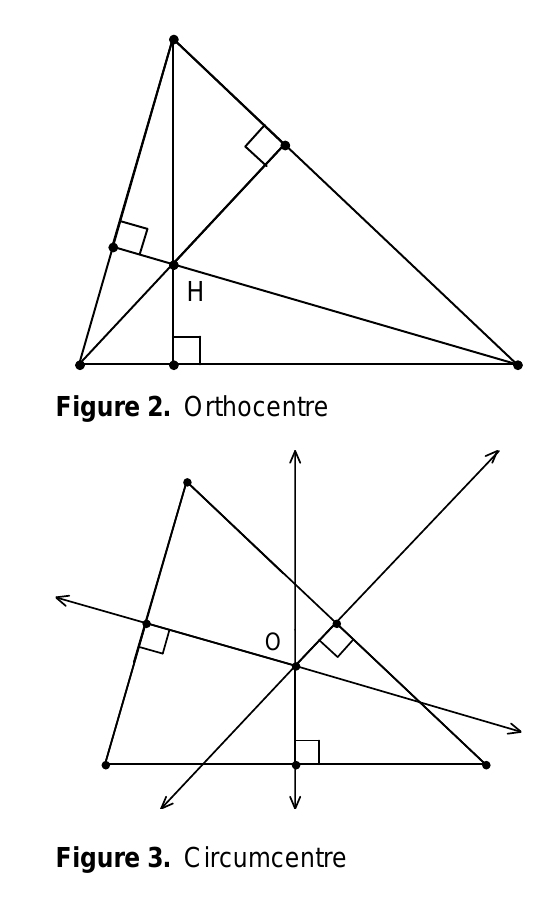
Figure 3. results from our geometric heritage. (1) The medians (lines from the vertices to the midpoints of the opposite sides) of a triangle are concurrent at the centroid (centre of gravity) of a triangle (see Figure 1). (2) The altitudes (perpendicular lines from the vertices to the opposite sides) of a triangle are concurrent at the orthocentre (see Figure 2). (3) The perpendicular bisectors of the sides (lines through the midpoints of the sides and perpendicular to them) of a triangle are concurrent at the circumcentre , which is the centre of the circle through the three vertices (see Figure 3).